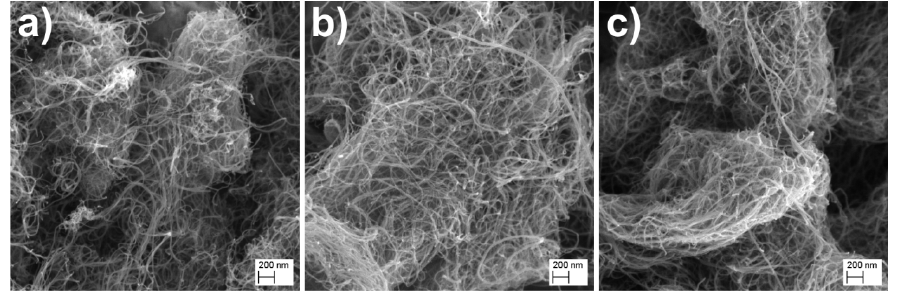
Figure 3. SEM images of ( a ) p MWCNTs ( b ) m MWCNTs and ( c ) m MWCNTs with adsorbed DOX.